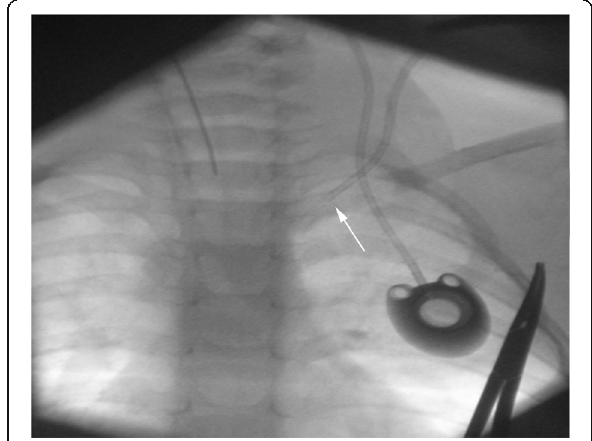
Fig. 2 Patient 2 intra-operative fluoroscopic picture. CVC inserted into the anterior branch of the EJV and failed to be threaded into the right atrium. The white arrow is pointing to the tip of the central venous